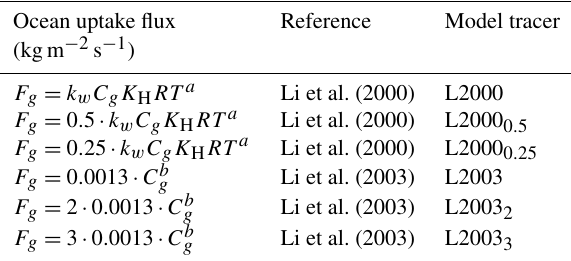
Table 3. HCN ocean uptake rates used for the different TOMCAT model